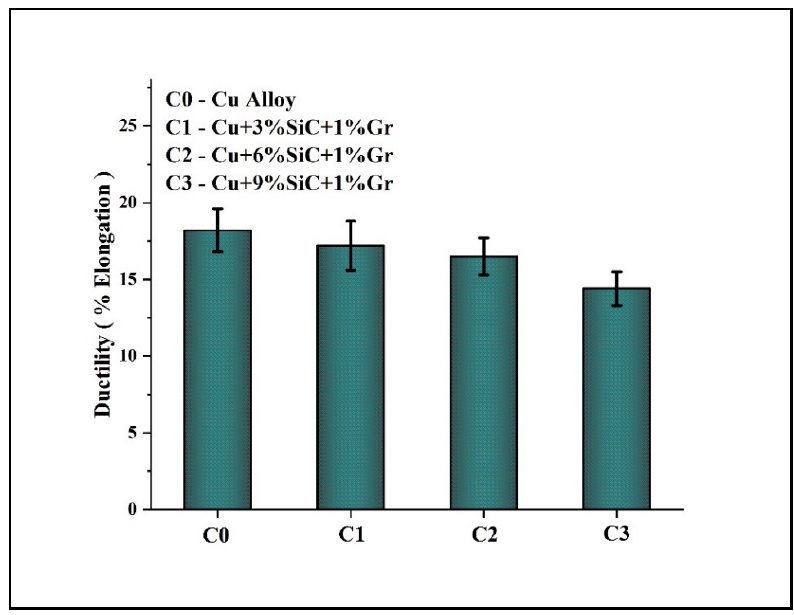
Appl. Sci. 2023 , 11 , x FOR PEER REVIEW Figure 15. Variation % elongation of Cu alloy and Cu-(3, 6, 9) wt.% SiC-Gr hybrid composites.